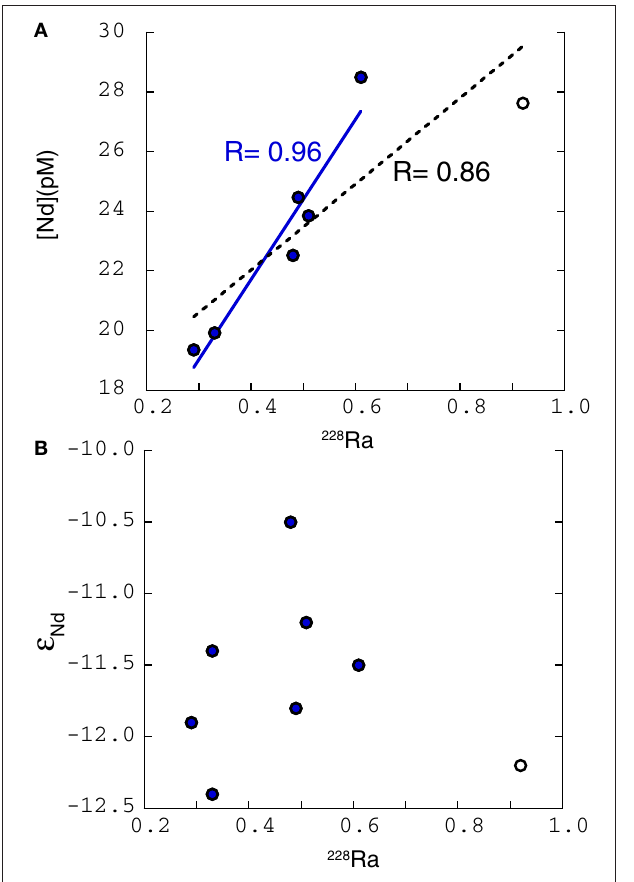
FIGURE 2 | Comparison of bottom water radium and neodymium (data from Charette et al., 2015; Stichel et al., 2015). (A) shows the positive correlation of the benthic-derived Ra with [Nd], consistent with a benthic source for both. (B) shows little correlation of ε Nd with Ra, although a correlation may not be expected between these variables. The unfilled datum is arbitrarily isolated: there is no reason to consider this datum contaminated.